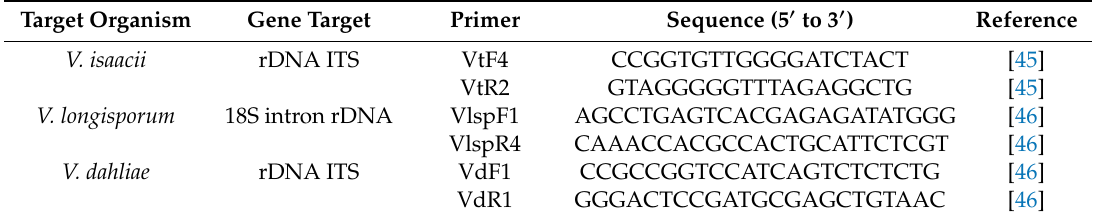
Table 6. Primers used to detect and quantify Verticillium spp. in plant and soil samples. Target Organism Gene